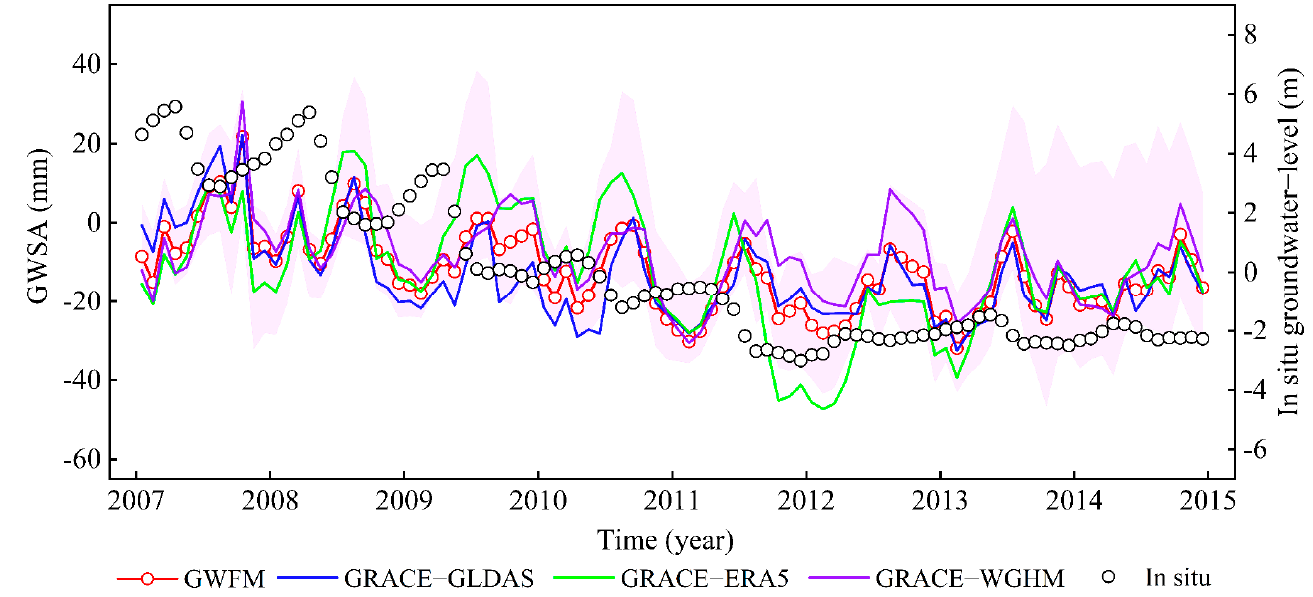
Figure 3. Comparisons of GWSA time series from GRACE − GLDAS, GRACE − ERA5, GRACE − WGHM, and GWFM and verified against in situ groundwater-level measurements. Table 2. Lagged CC between in situ groundwater-level measurements and GWSA in S1–S5 from 2007 to 2014. Time Lag (Month) Wells